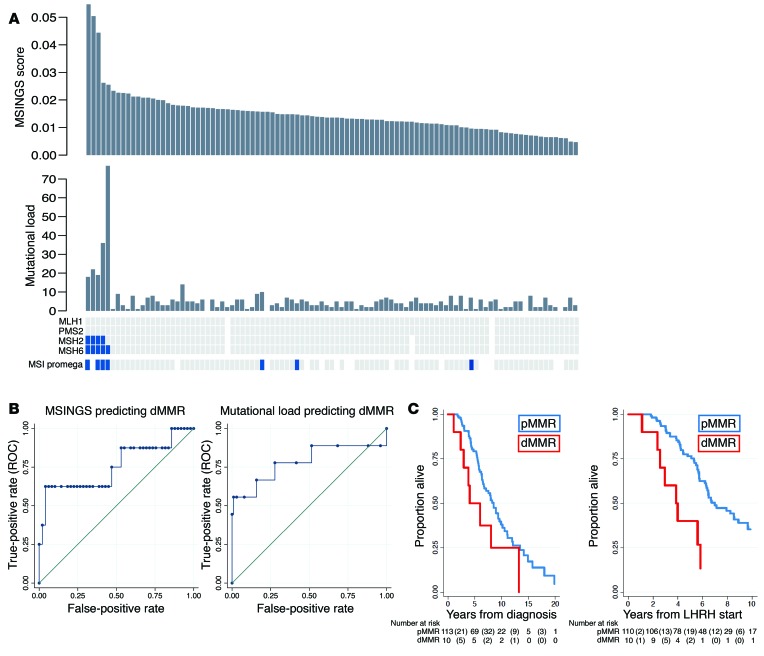
Comparative orthogonal analyses of dMMR in mCRPC.(A) Methods for detecting dMMR in 127 CRPC tumors from 124 patients with NGS available (samples sorted by MSINGS). From top to bottom: MSI by NGS (dMMR_MSINGS); mutational load per panel after SNP filtration; IHC for MLH1, PMS2, MSH2, MSH6 (blue marks absence of the protein); dMMR_MSI by PCR in blue. White indicates samples not assessable for analysis. Results for 1 dMMR patient are not shown, since MSINGS for this samples failed QC. (B) MSINGS score cutoff of 0.024 had sensitivity (SE) of 60% and specificity (SP) of 98% for predicting dMMR_IHC or dMMR_MSI, with an area under the ROC curve (AUC) of 0.79. ML ≥5.5 mutations had SE = 78% and SP = 72% for predicting dMMR_IHC or dMMR_MSI (AUC = 0.75). (C) Kaplan-Meier survival curves from diagnosis (left) according to MMR status (median OS [mOS], 8.5 years; interquartile range [IQR], 5.5–13.5 years for pMMR vs. 4.1 years; IQR, 2.9–8.0 years for dMMR; log-rank test P = 0.07). Kaplan-Meier survival curves from LHRH initiation (right), according to MMR status (mOS, 7.0 years; IQR, 5.3–13.5 years for pMMR vs. 3.8 years; IQR, 2.5–5.8 for dMMR; log-rank test, P = 0.003).